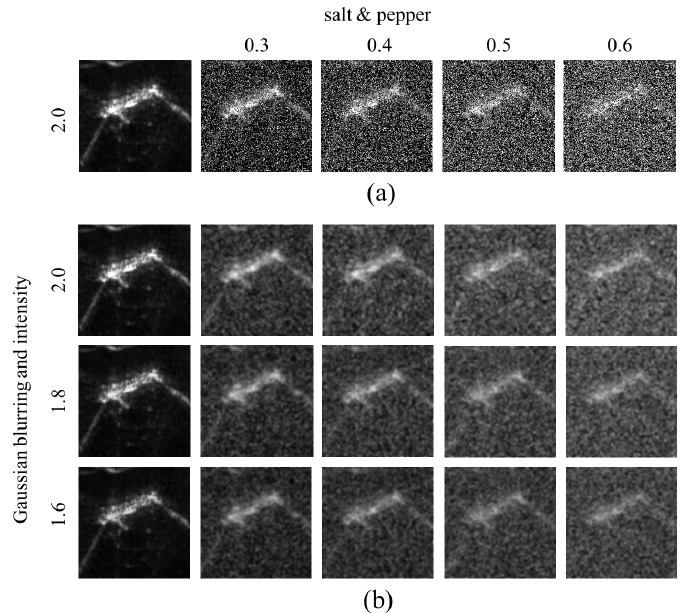
Figure 3. Images according to the noise density of ‘salt & pepper’ effect, Gaussian blurring, and pixel intensity for the training dataset. The background of the target caused noise to the sonar image, so ‘salt & pepper’ noise to the CKI was applied in ( a ) and then blurred in ( b ). The image sharpness of ( b ) was varied by adjusting the pixel intensity because the sharpness can be differed according to the inclined angle of the sonar